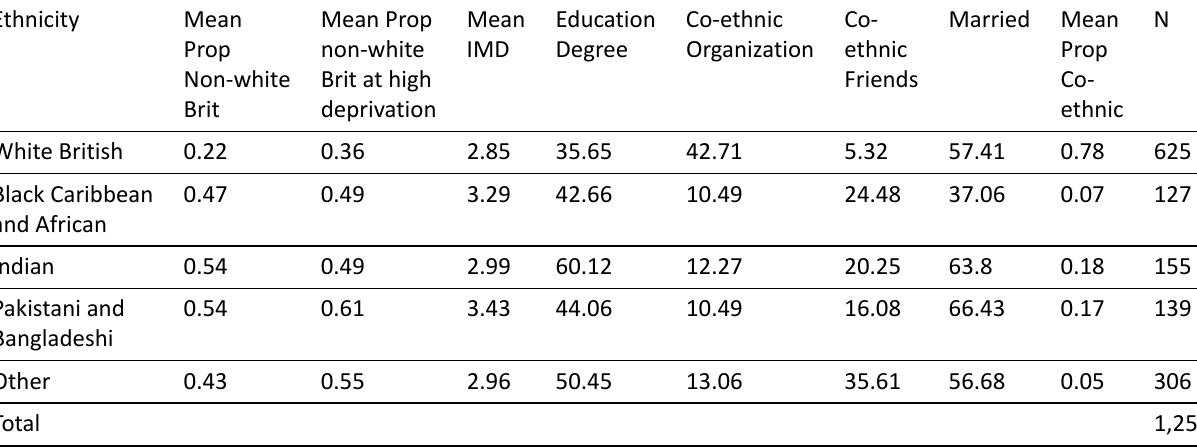
Table 1. Demographic, socio-economic, and community characteristics by ethnic group. Source: MCDS (2010); 298 retired and 113 in full time education respondents excluded from working age sample of